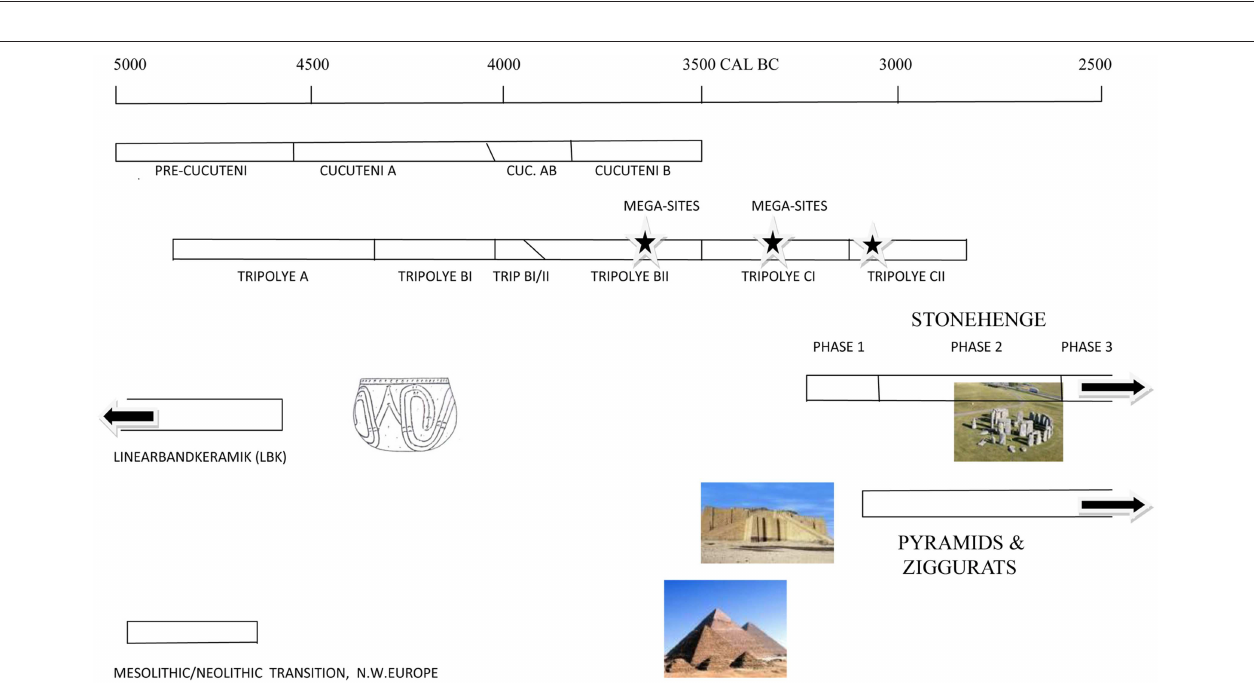
FIGURE 1 | Map of cultural groups constituting Old Europe, with inset showing location of the Nebelivka megasite (M. Nebbia).